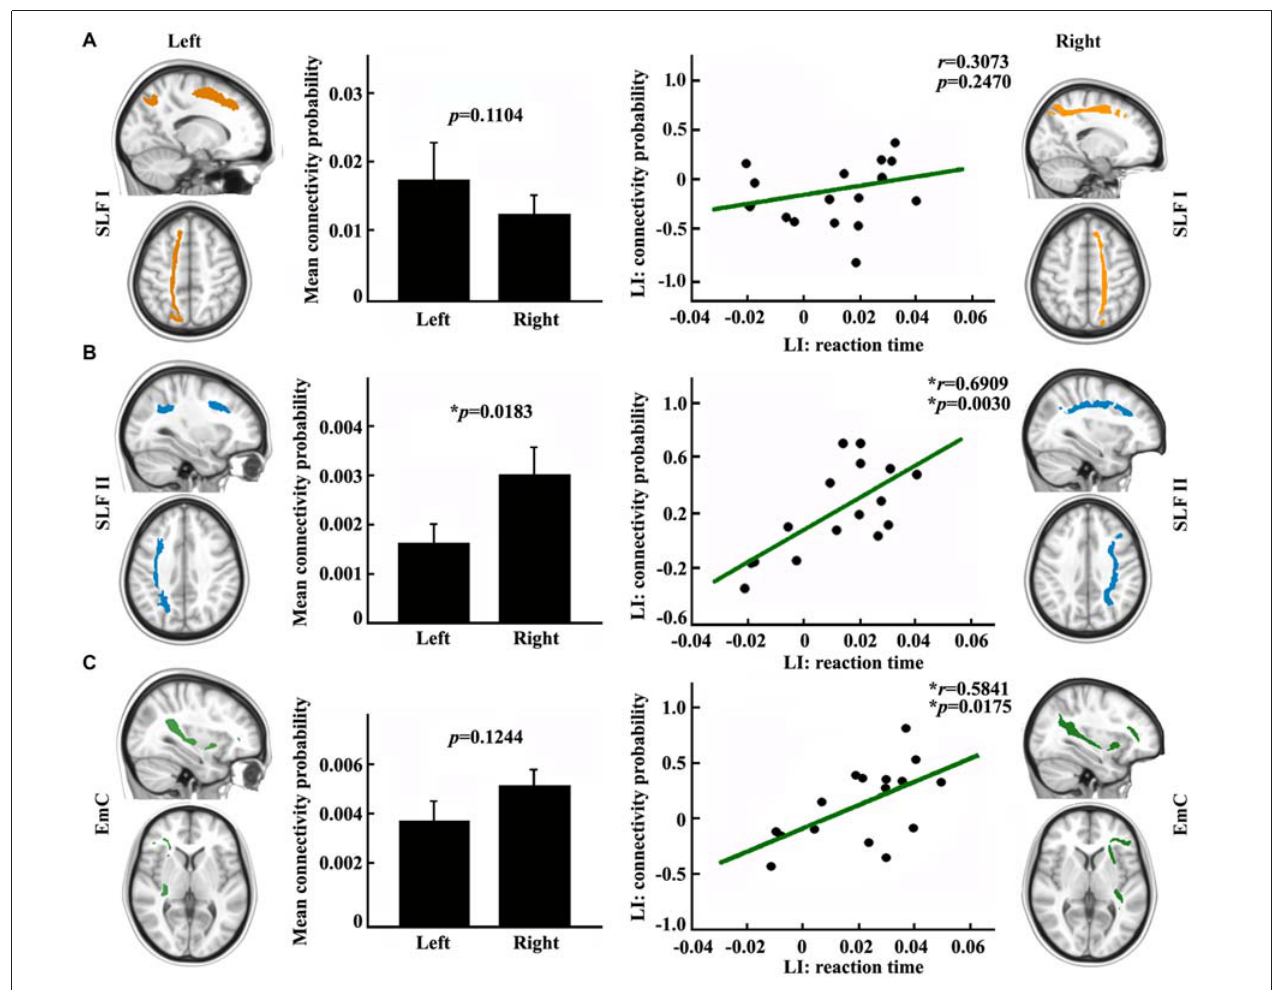
FIGURE 3 | Anatomical connections mapping analyses between the posterior SPL and the frontal subregions. (A) The white matter pathway of superior longitudinal fasciculus (SLF) I between the posterior SPL and the superior frontal gyrus (SFG) is shown in the upper panel. The mean anatomical connectivity probability and the standard error and correlation analysis for the laterality index (LI) of anatomical connections of the posterior SPL to the SFG and the LI of the reaction time are also portrayed in the upper panel. (B) The white matter pathway of SLF II between the posterior SPL to the middle frontal gyrus (MFG), the mean anatomical connectivity probability and the correlation analysis for the LI of the anatomical connections of the posterior SPL to the MFG and the LI of the reaction time are delineated in the middle panel. (C) The fibers of extreme capsule (EmC) between the posterior SPL to the inferior frontal gyrus (IFG), mean anatomical connectivity probability, and the correlation analysis for the LI of the anatomical connections of the posterior SPL to the IFG and LI of the reaction time are delineated in the lowest panel. The unit of reaction time is second (s). * Represents the statistically significant difference; false discovery rate (FDR) corrected, p < 0.05 for